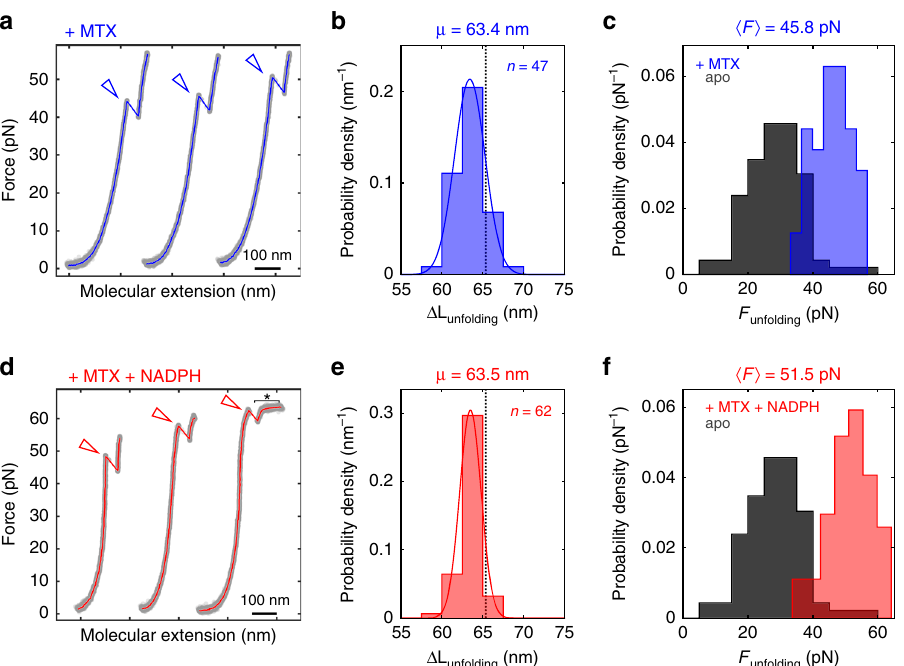
Fig. 3 Ligands stabilize mDHFR mechanically. a , d Example force-extension curves of initial mDHFR unfolding events (arrowheads) in the presence of MTX ( a , blue) and MTX + NADPH ( d , red). Unfolding occurs mostly above 40 pN. When both ligands are present, some of the unfolding events occur in the force range of DNA overstretching ( d , asterisk). b , e Contour length changes for initial unfolding events from 47 molecules and 62 molecules of either MTX only ( b ) or MTX + NADPH ( e ). The means ( µ ) of normal distribution fi ts (solid lines) to the data are very similar to each other and close to the calculated value of 65.4 nm (dotted lines). c , f Unfolding force histograms for the two ligand conditions. Data obtained for apo-mDHFR (dark gray; same as in Fig. 2f) are plotted for reference. The ligands additively stabilize mDHFR. The narrower unfolding force distributions are consistent with unfolding from single states in both ligand conditions. The average unfolding forces ( 〈 F unf 〉 ) are indicated on top of the panels. Source data are provided as a Source Data fi